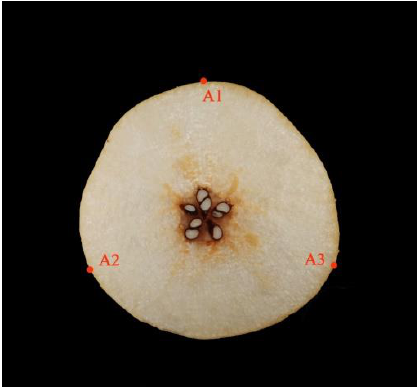
Figure 2. Plot of three measurement points ( A1 , A2 , A3 ), which are marked around the pear equator and separated by 120°.